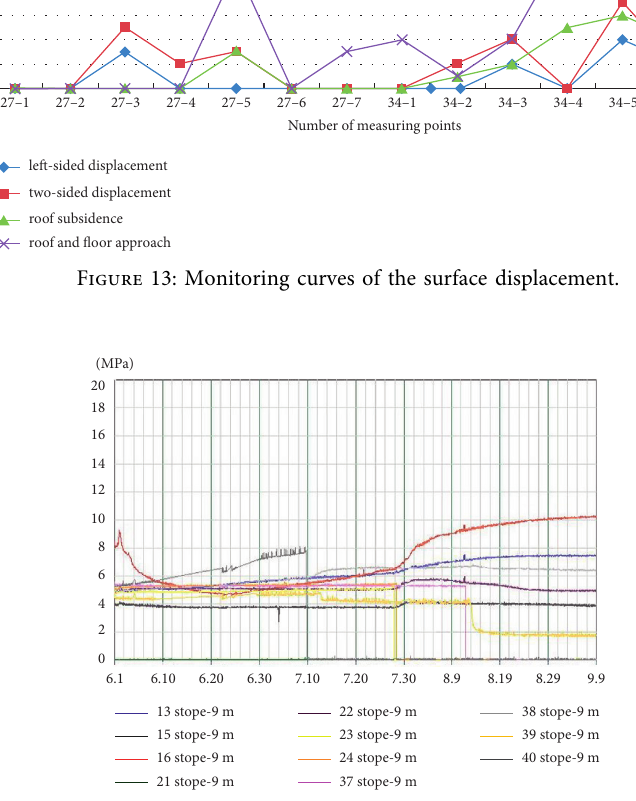
Figure 14: Monitoring curves of coal